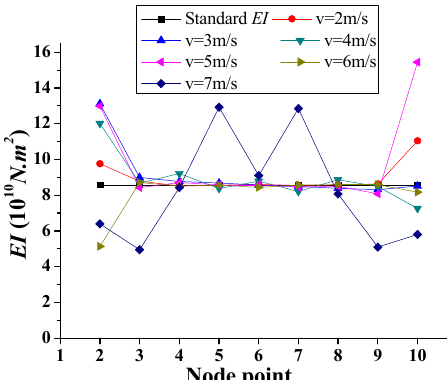
Figure 8. Simulation results of calculated EI with different test vehicle speeds.